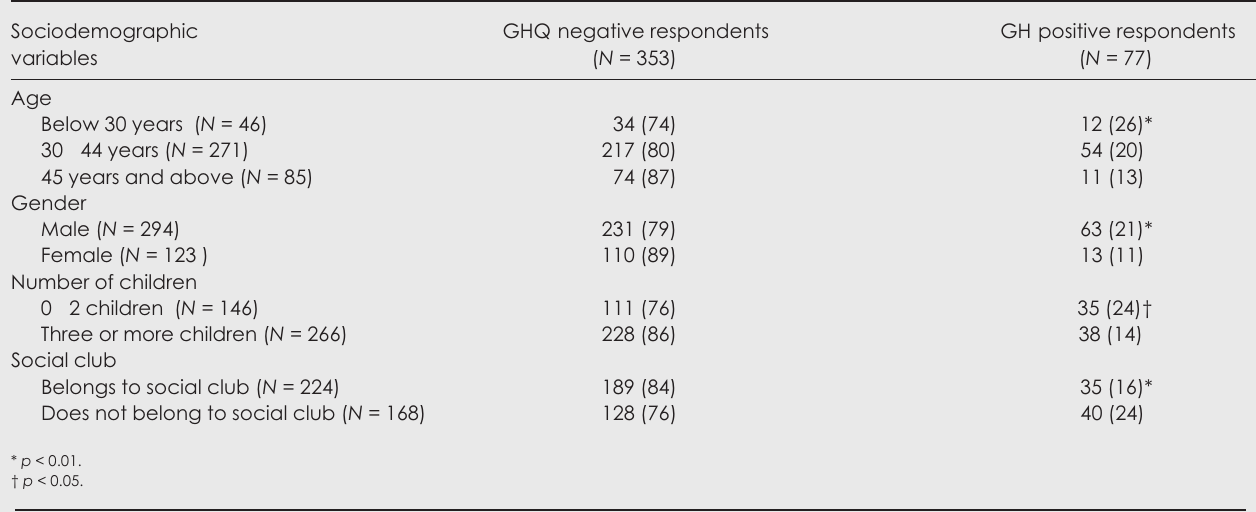
Table I. Sociodemographic characteristics of respondents ( N (%))